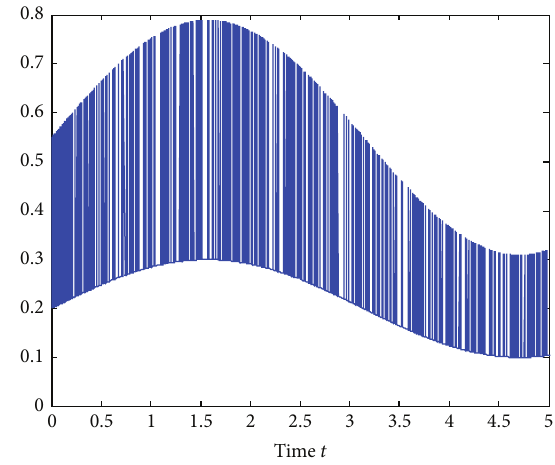
Figure 1: Random coupling strength 𝑐 1 (𝑡) .